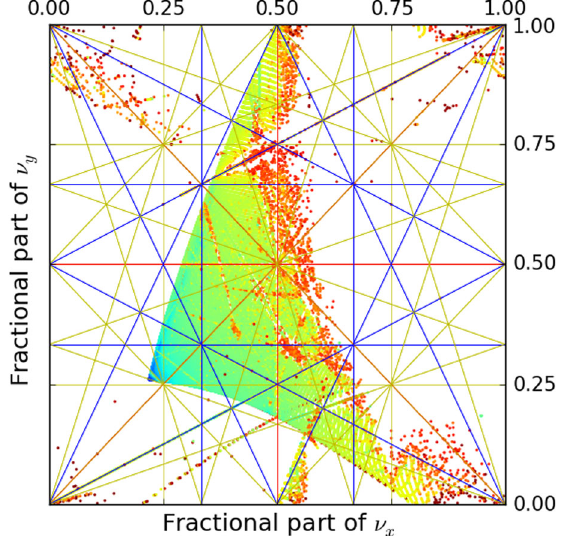
FIG. 9. Frequency map corresponding to the on-momentum dynamic aperture in the x – y planes. A large tune-shift-with- amplitude is observed in this lattice. The third order resonance line can be crossed stably (without obvious diffusion).